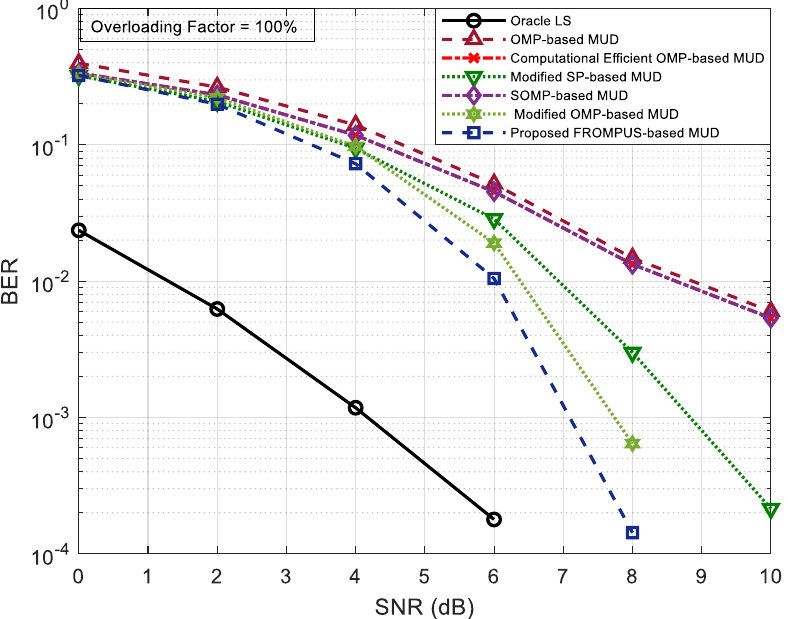
Figure 3. Achievable BER versus SNR performance of the FROMPUS-based MUD in comparison with five other MUDs: overloading factor= 100%, ℑ = 20 , and 𝑇 = 7